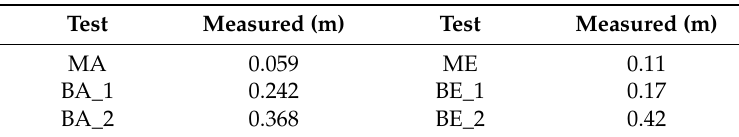
Table 8. Maximum runup measured within the first three min of each step for bichromatic and monochromatic tests. Test Measured (m) Test Measured (m) MA 0.059 ME 0.11 BA_1 0.242 BE_1 0.17 BA_2 0.368 BE_2